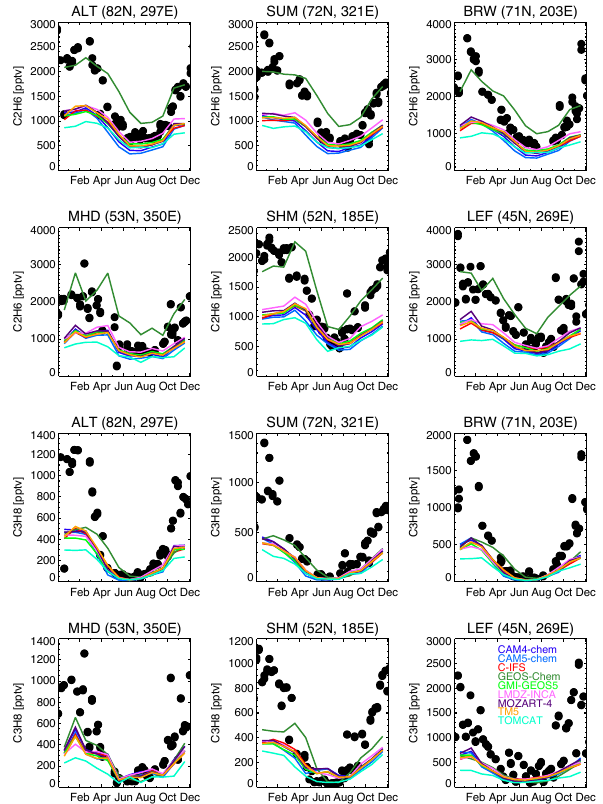
Figure 11. Ethane (top six panels) and propane (lower six panels) at several Northern Hemisphere NOAA GMD network sites. Monthly mean model output (colored lines) is plotted with 2008 weekly ob- servations (black circles). Station codes: ALT: Alert, Canada; SUM: Summit, Greenland; BRW: Barrow, Alaska; MHD: Mace Head, Ire- land; SHM: Shemya, Alaska; LEF: Wisconsin.